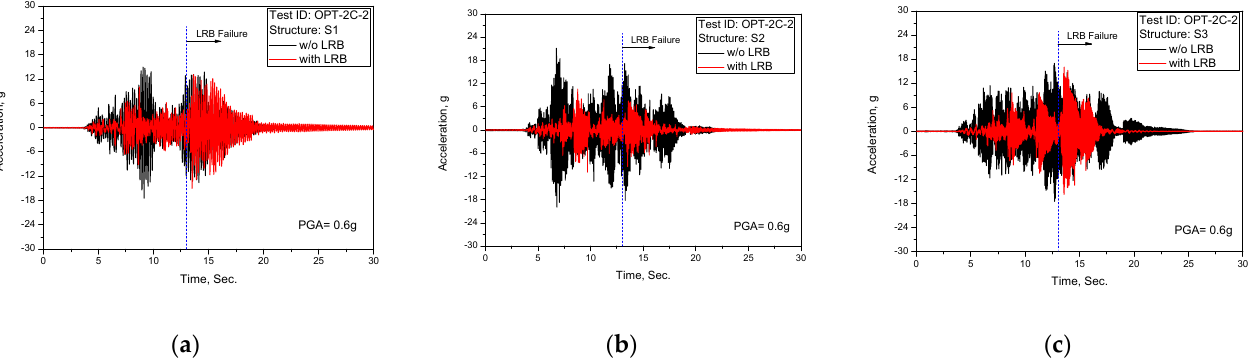
Figure 13. Test results of acceleration time history response (TEST ID: OPT-2C-2, PGA = 0.6 g): ( a ) S1; ( b ) S2; ( c ) S3.